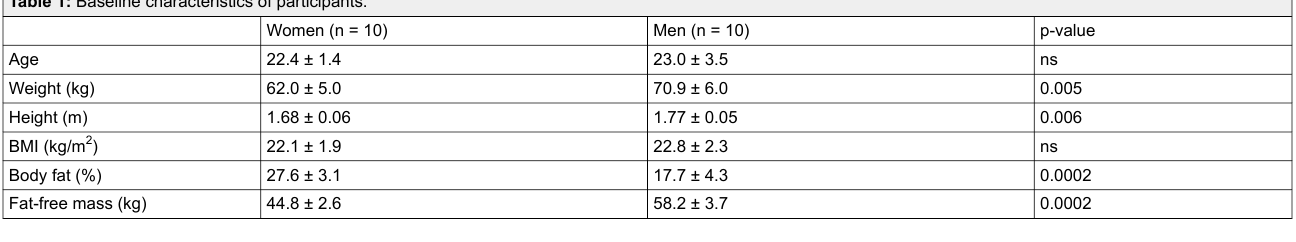
Table 2: Exercise sequence.